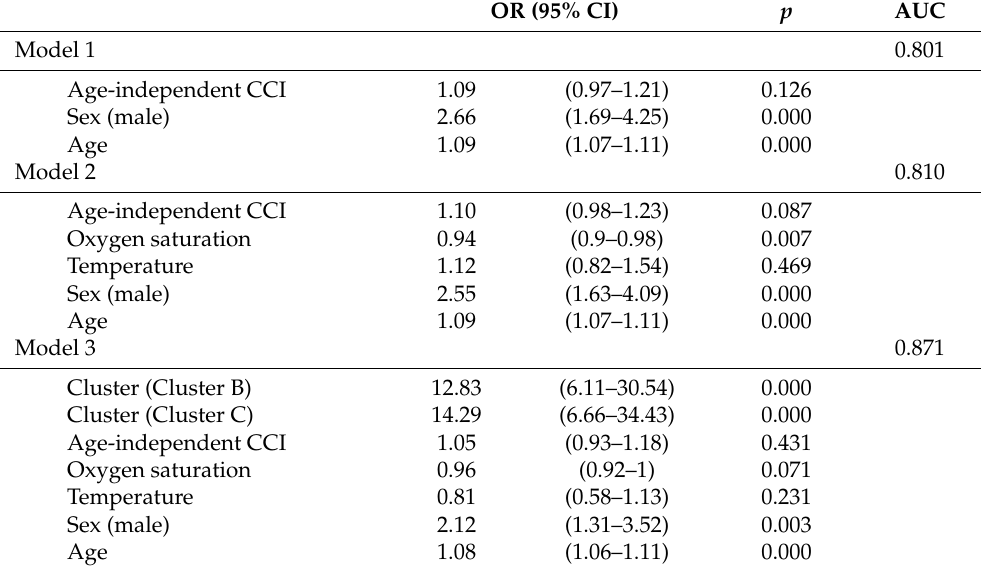
Table 3. Logistic regression model for the risk of death.